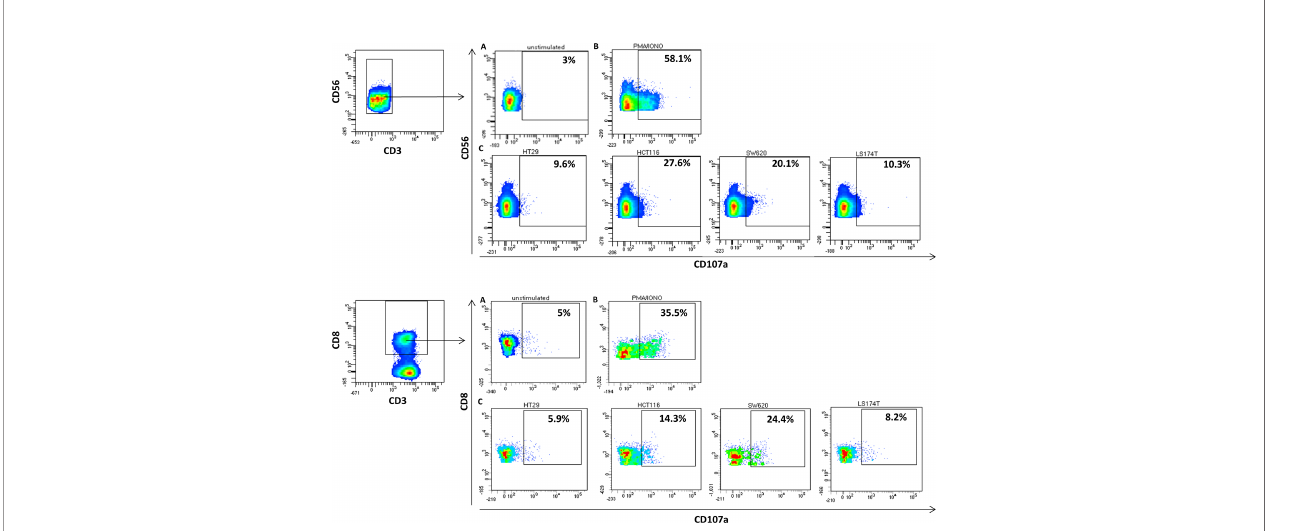
FIGURE 4 | Differential cytotoxic activity in colon cancer oligometastatic patients (representative CD107a degranulation assay). Upper panel, NK-puri fi ed cells were gated based on (CD56 + CD3 − ) (A) spontaneous, (B) PMA/IONO-induced, and (C) human colon cancer cell line-induced NK degranulation. Lower panel, T cells were gated based on (CD8 + CD3 + ) (A) spontaneous, (B) PMA/IONO-induced, and (C) human colon cancer cell line-induced CD8 + T-cell degranulation.